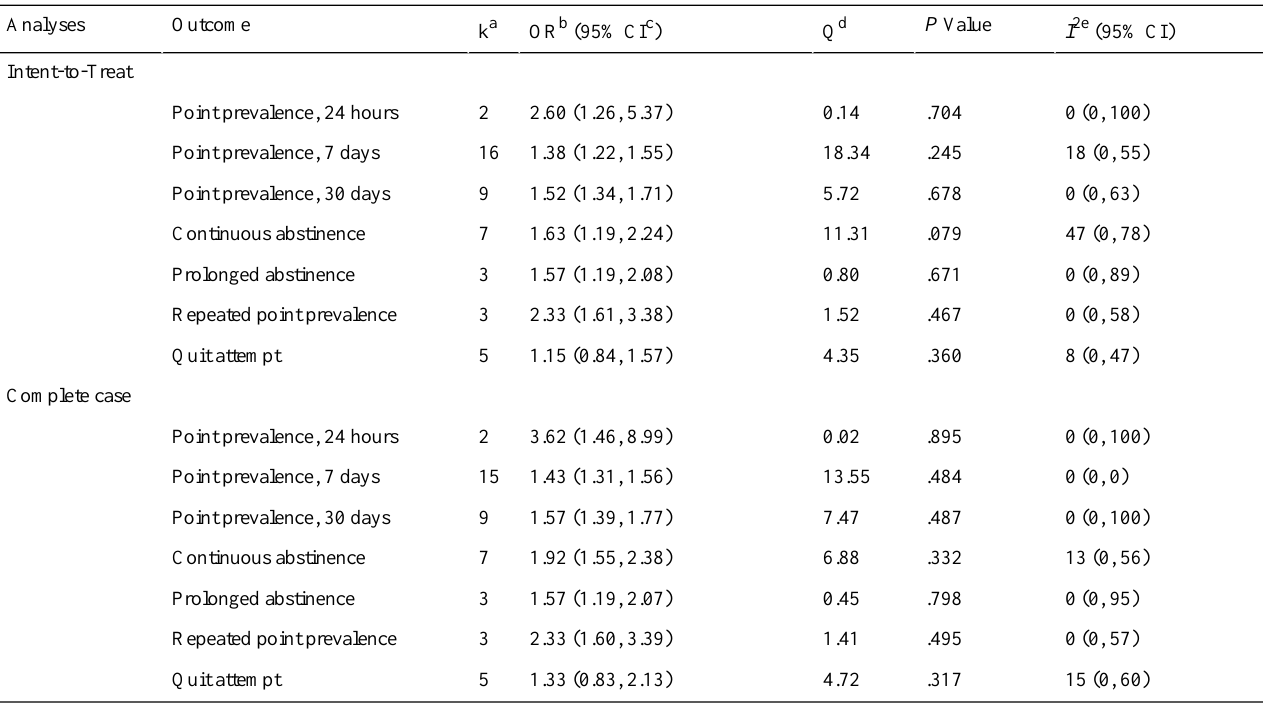
Table 3. Summary effect sizes and homogeneity statistics (random effects assumptions) at the final post-intervention assessment for smoking abstinence and quit attempts.